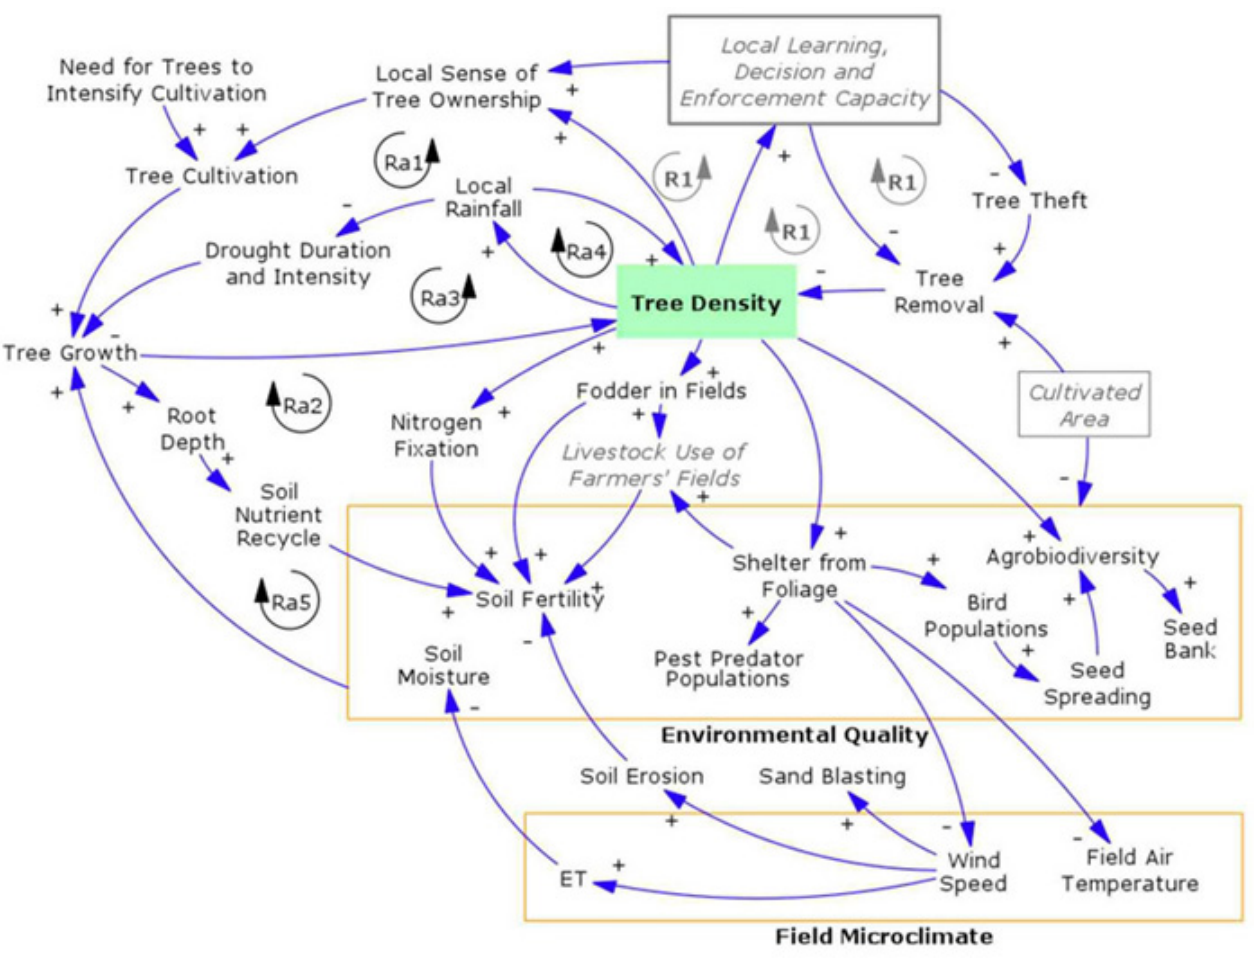
Fig. 5 . Trees and environment: relations between biophysical (trees, soil, water, and atmosphere) and socio-political (institutions, social capital), modeled at the field-to-village